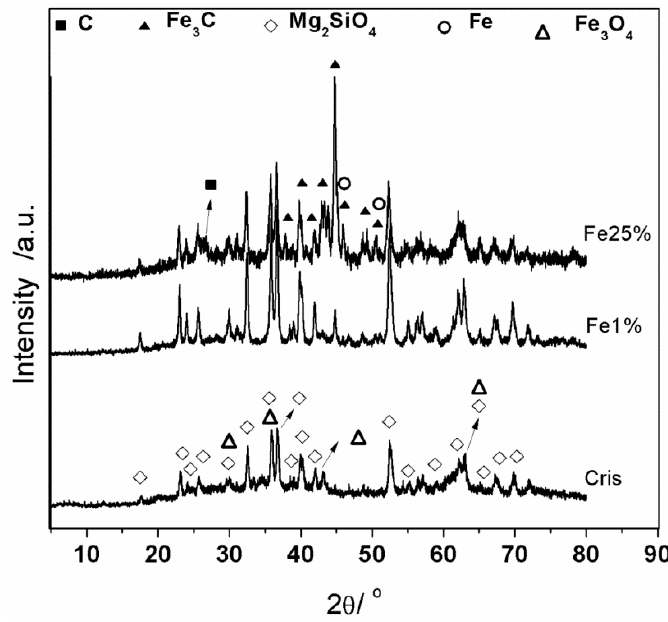
Figure 5. XRD patterns for Cris, Fe1% and